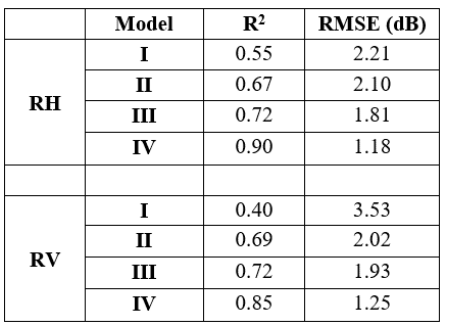
Table 4. Model wise R 2 and RMSE statistics for RH and RV